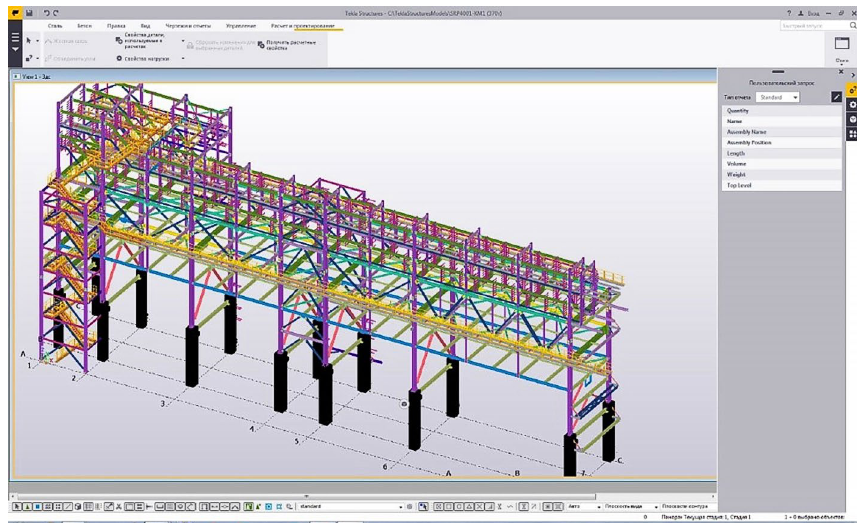
Figure 5. A physical model for the structure applying Tekla Structures software